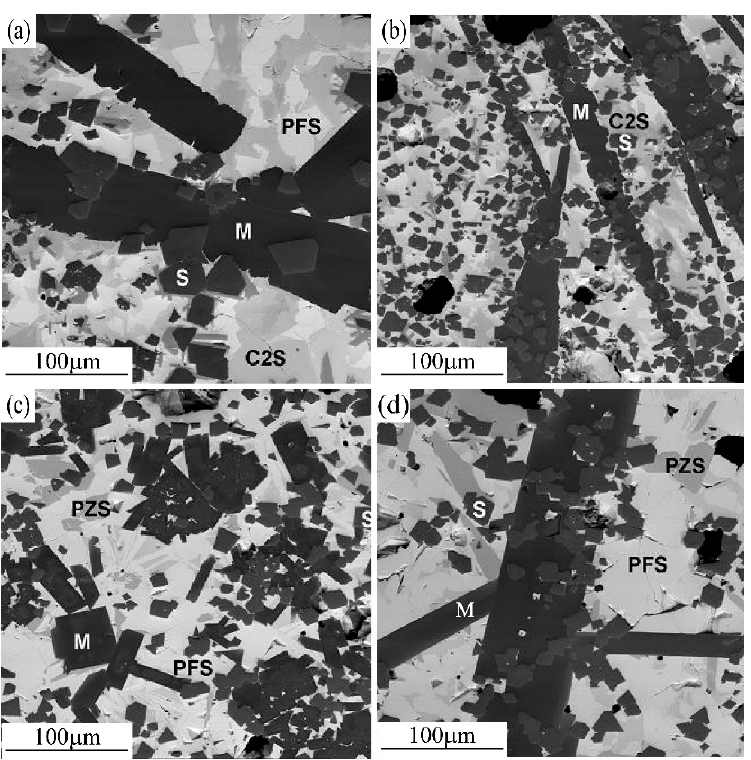
Figure 2. Typical microstructures of slow-cooled lead-rich slags: Y2 ( a , b ) and Y3 ( c , d ). S = spinel, M = melilite, PFS = 6PbO · FeO 1.5 · SiO 2 , C2S = Ca 2 SiO 4 , PZS = PbZnSiO 4 . Table 3. Compositions of the phases present in the melted slags measured by